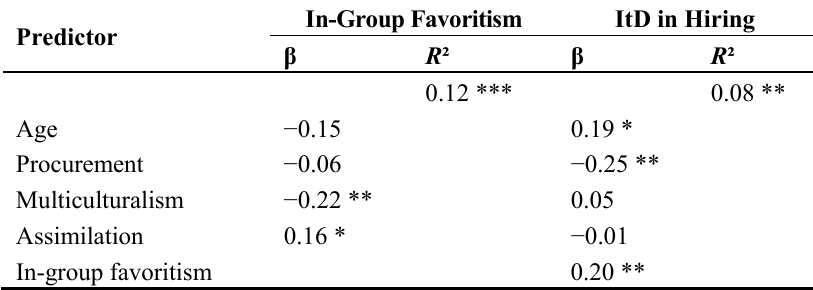
Table 3. Regression coefficients for model testing the effects of interethnic ideologies on the intention to discriminate through in-group